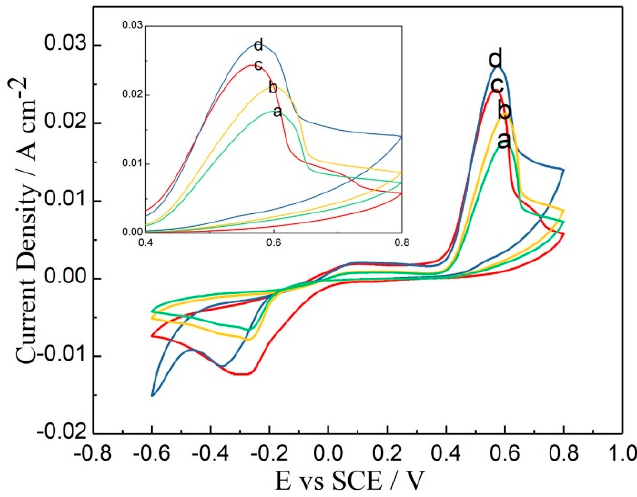
Figure 1. Cyclic voltammetry scans of the Sb-Te films at room temperature at a scan rate of 0.05 V/s with electrolytes containing 8 mM of SbO + and ( a ) 8, ( b ) 10, ( c ) 12, and ( d ) 15 mM of HTeO 2+ .